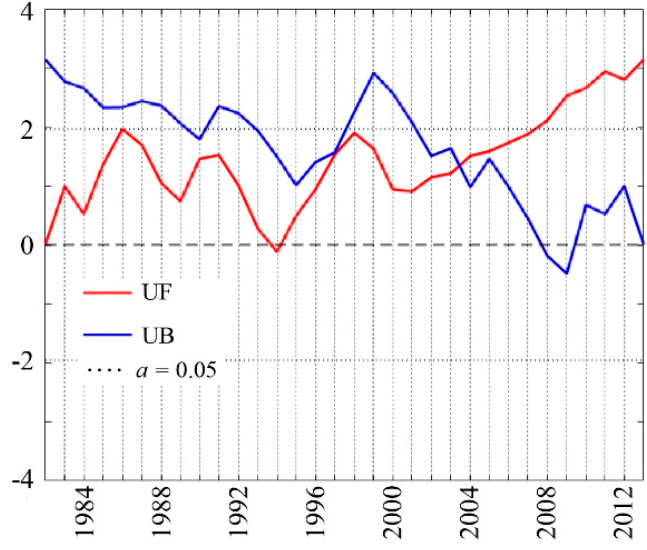
Figure 3. Mann–Kendall test of GIMMS3g NDVI during 1982 to 2013.